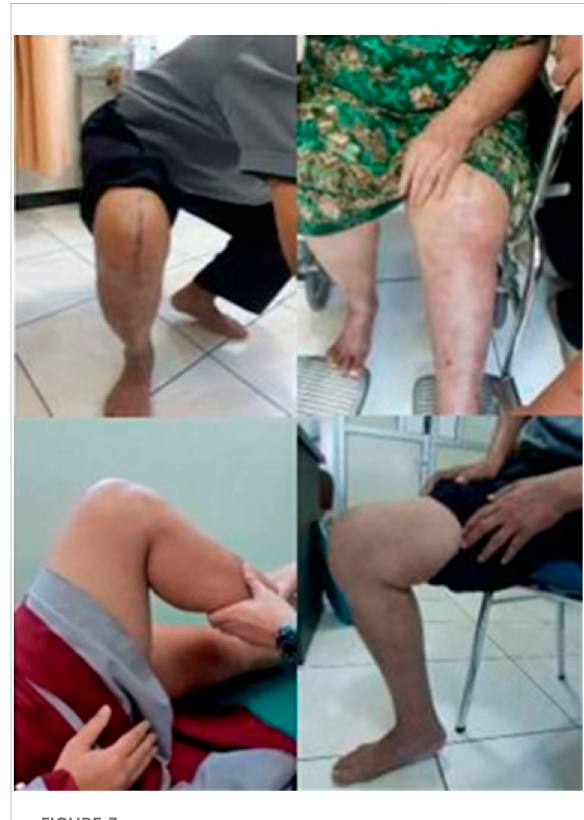
FIGURE 3 Limited range of fl exion angle in postoperative TKA